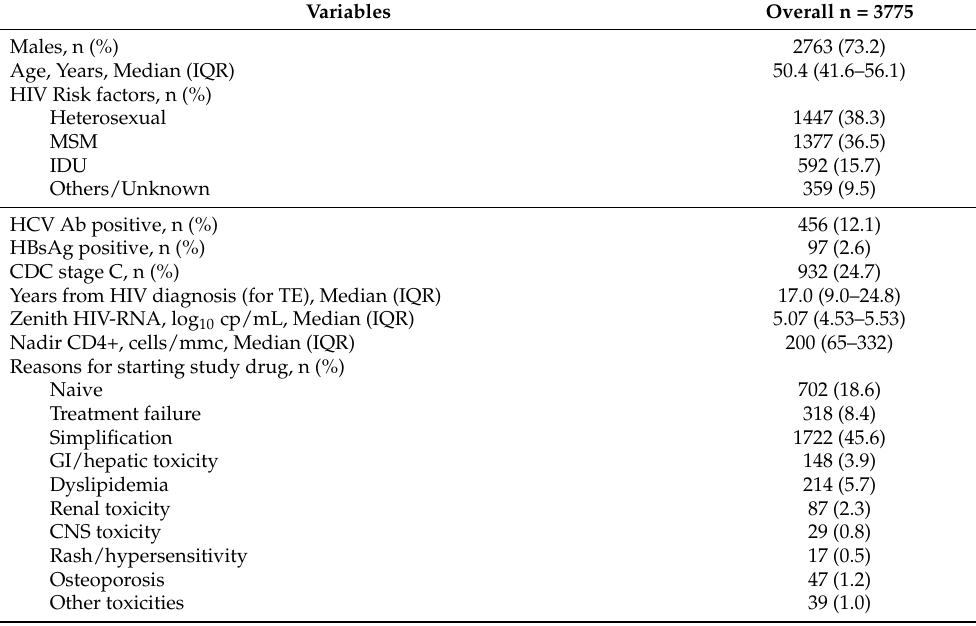
Table 1. Characteristics of the study